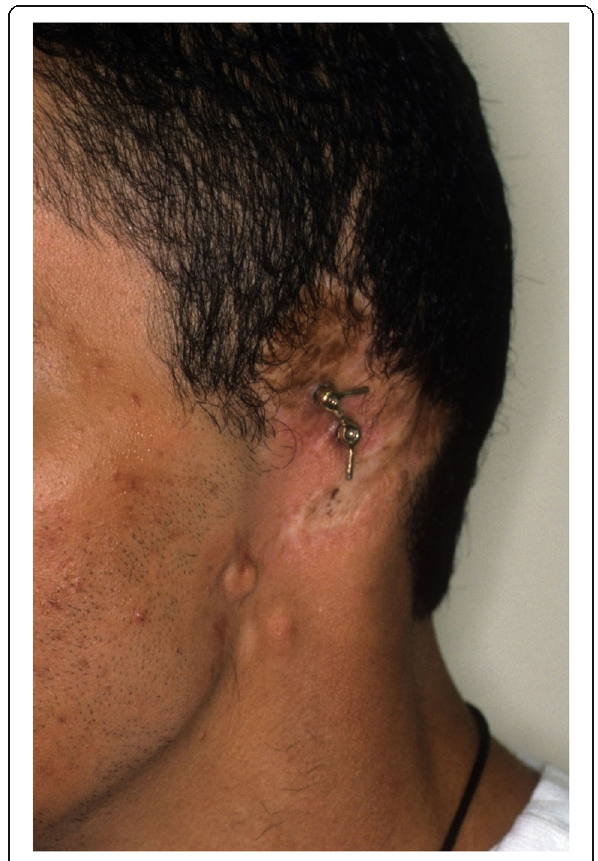
Fig. 8 Bar framework attached to implants